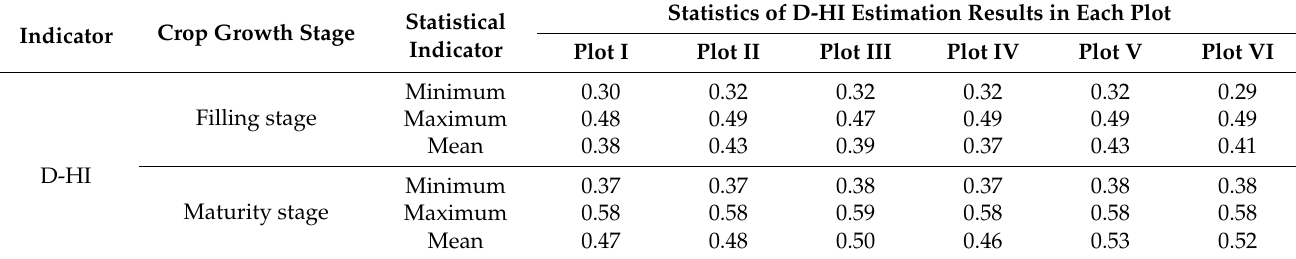
Figure 14. D-HI estimation results based on the sensitive band centers λ (724 nm, 784 nm) (4 June 2021). Table 5. Statistics of spatial D-HI estimation results for each plot in different periods. Crop Growth